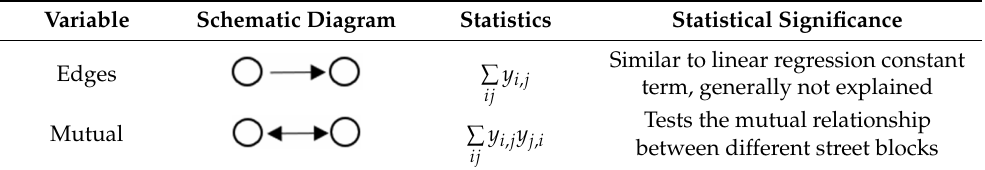
Table 2. ERGM variables description.